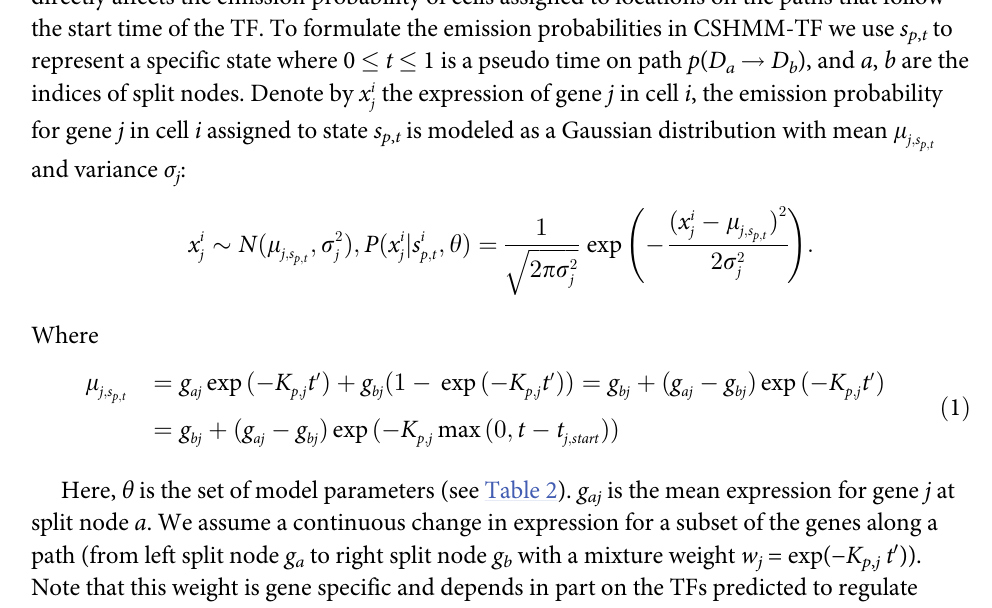
Table 2. Parameters of the CSHMM-TF model: θ symbol